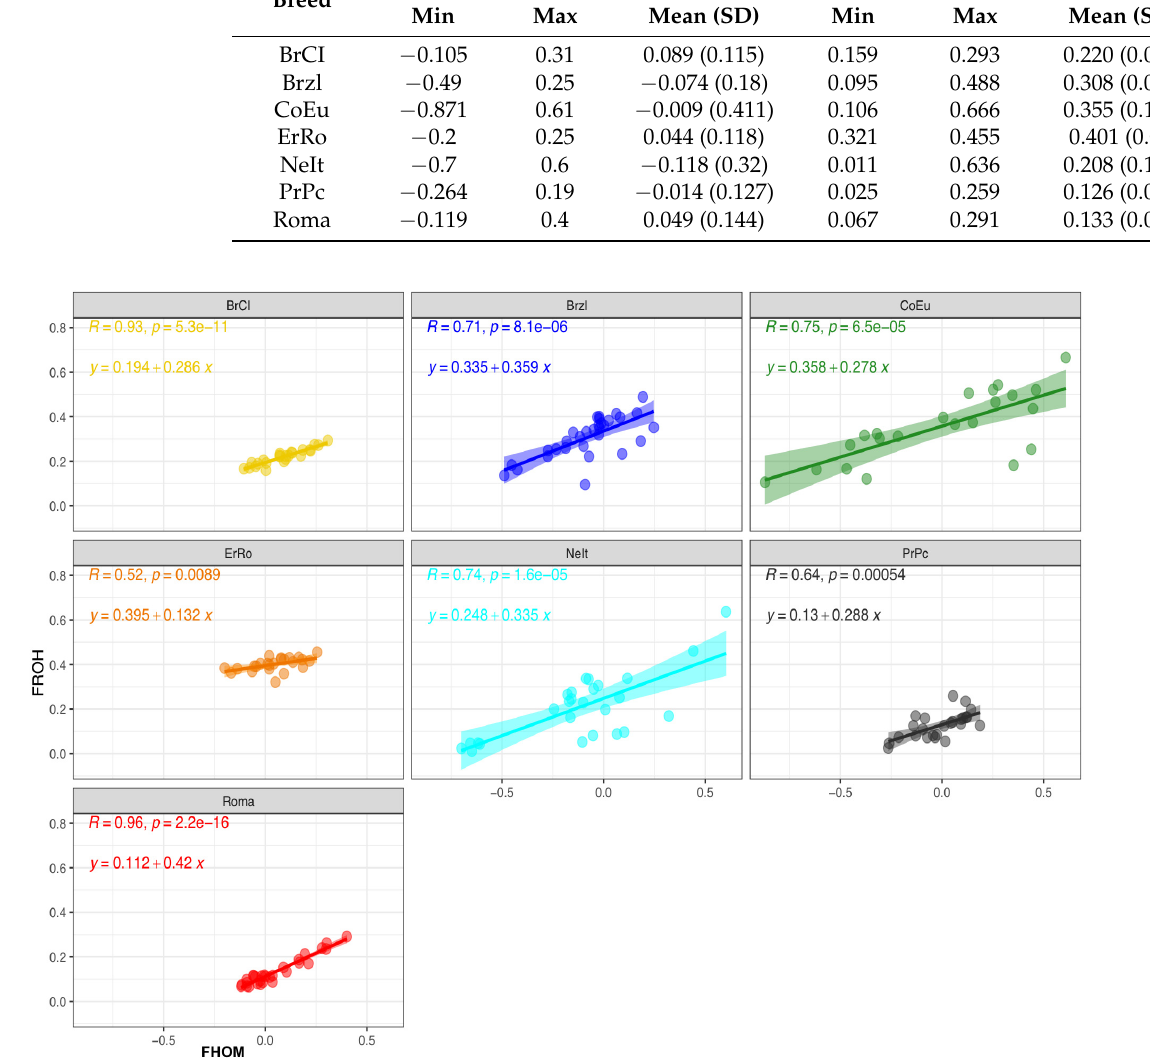
Figure 7. Linear regression and correlation values together with descriptive statistics for F HOM and F ROH (Table 4) in each turkey breed.